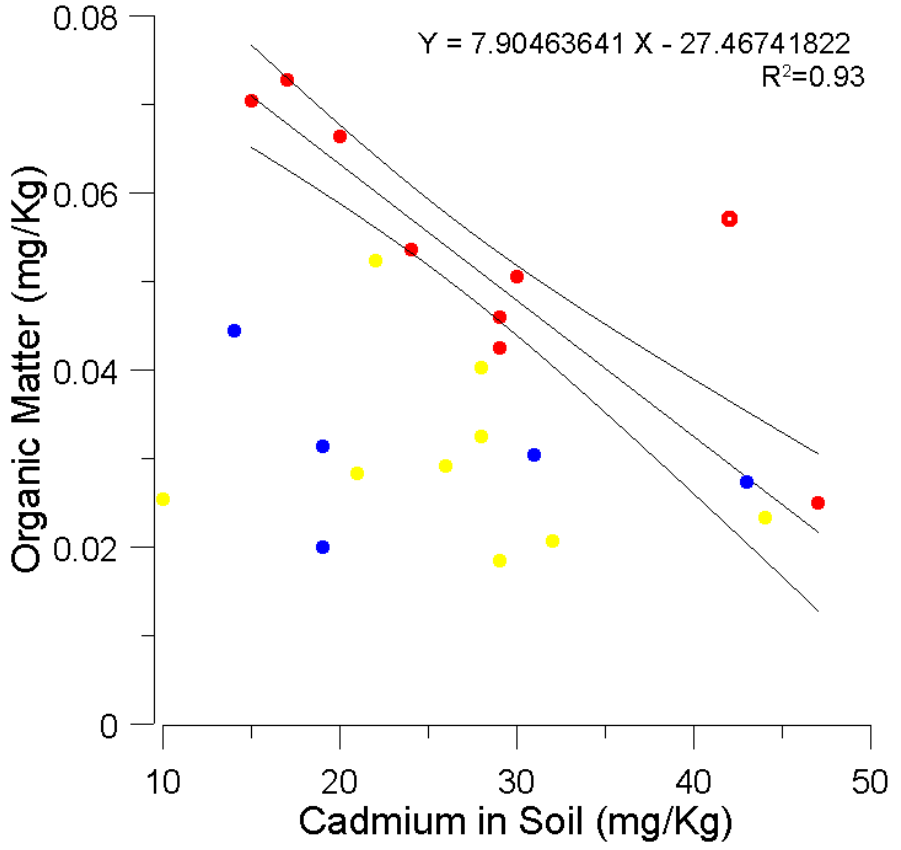
Figure 7. Correlation between cadmium in soils and organic matter content. Farm 1 is indicated in red, Farm 2 is indicated in yellow and Farm 3 is shown in blue. A linear fit has been added only for Farm 1 and the 95% confidence interval is shown; the void red dot has been excluded as an outlier.